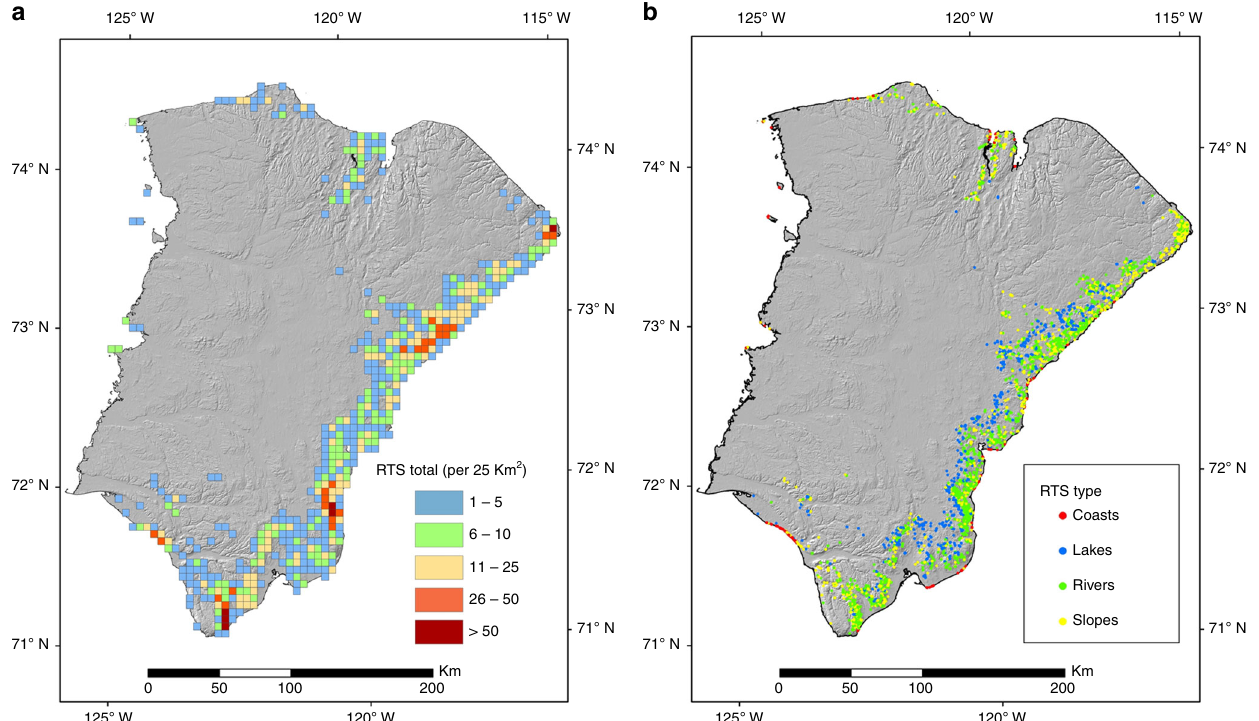
Fig. 5 Distribution of all active retrogressive thaw slumps (1984 – 2015). a Spatial concentration (25 km 2 grid cells). b Distribution by locus of